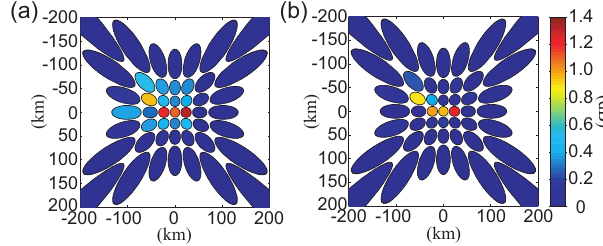
Fig. 9. (a) CNA calculated by using the differential flux recon- structed from ALIS images only. (b) CNA obtained by using the differential flux reconstructed from both auroral images and CNA.